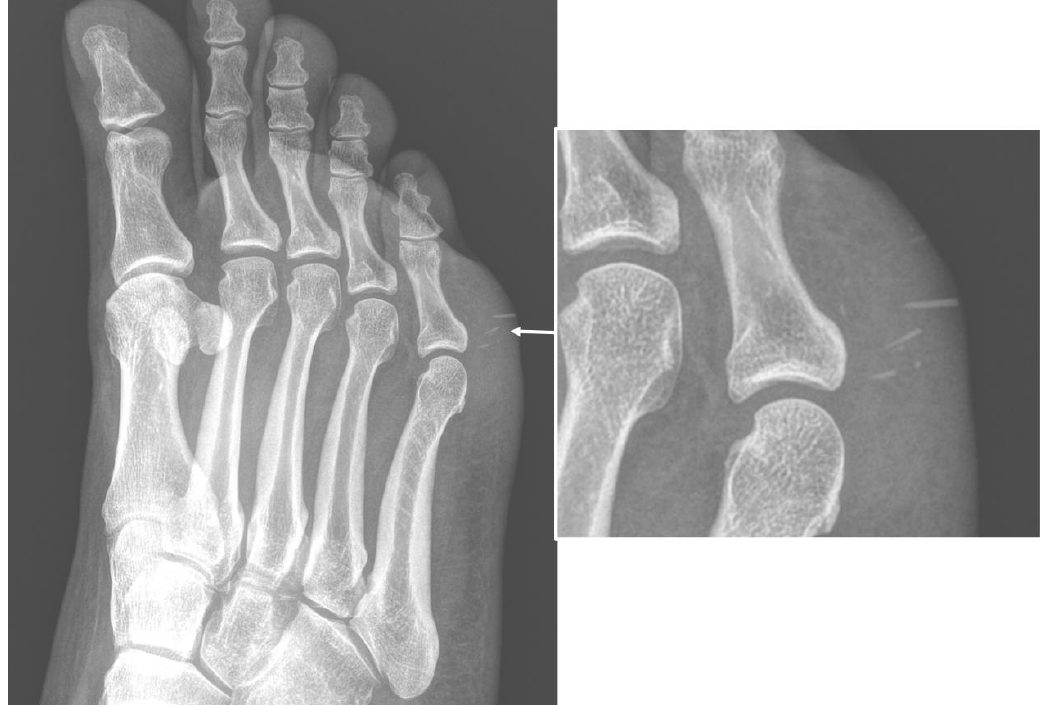
Figure 1. Conventional radiography (anterior – posterior oblique projection) of the right foot in a 44-year-old woman, who were presented to the emergency department with complaints about worsening pain and swelling in the plantar external region. The examinations confirmed local swelling of soft tissue and revealed the presence of thin foreign bodies, sea urchin quills (arrows and in enlargement), which was confirmed after surgical excision and anamnestic confirmation.